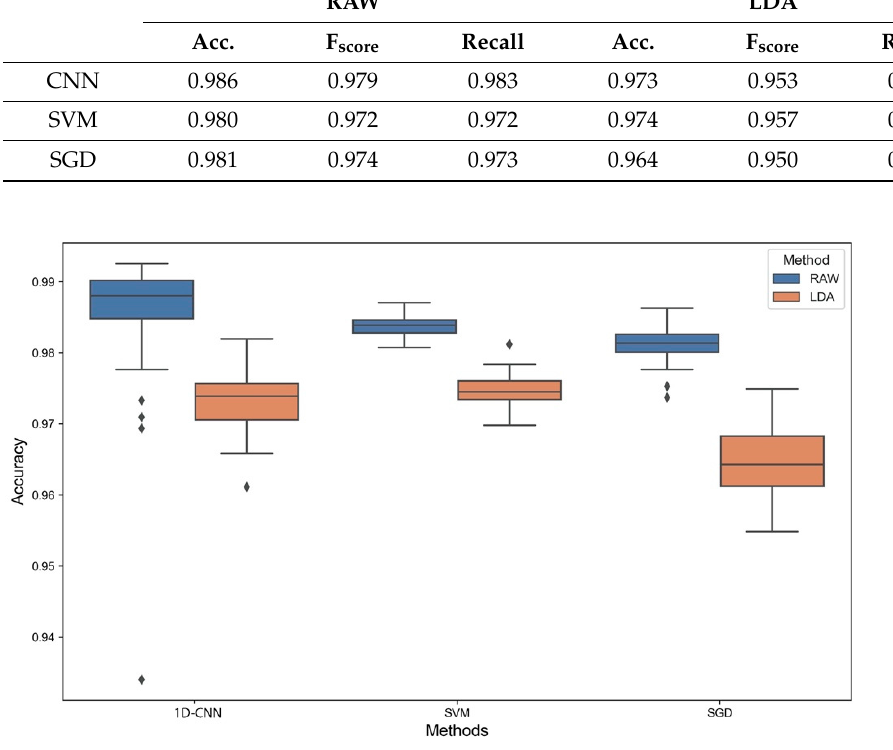
Table 2. Classification accuracy assessment.